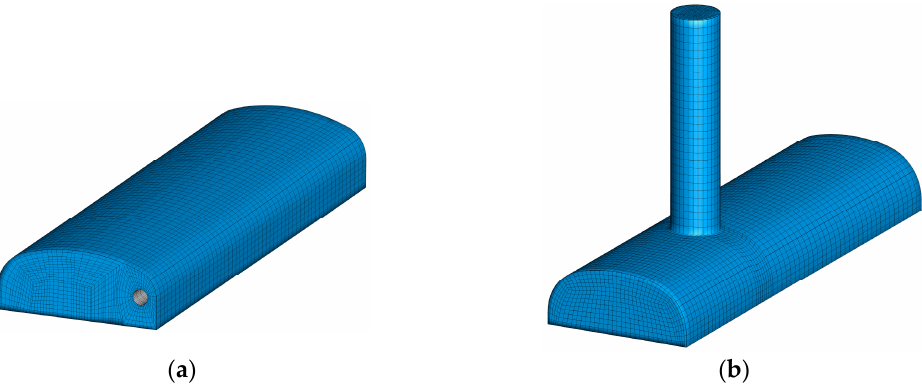
Figure 6. Local grids. ( a ) Forced ventilation scheme; ( b ) Axial-flow gallery ventilation scheme.